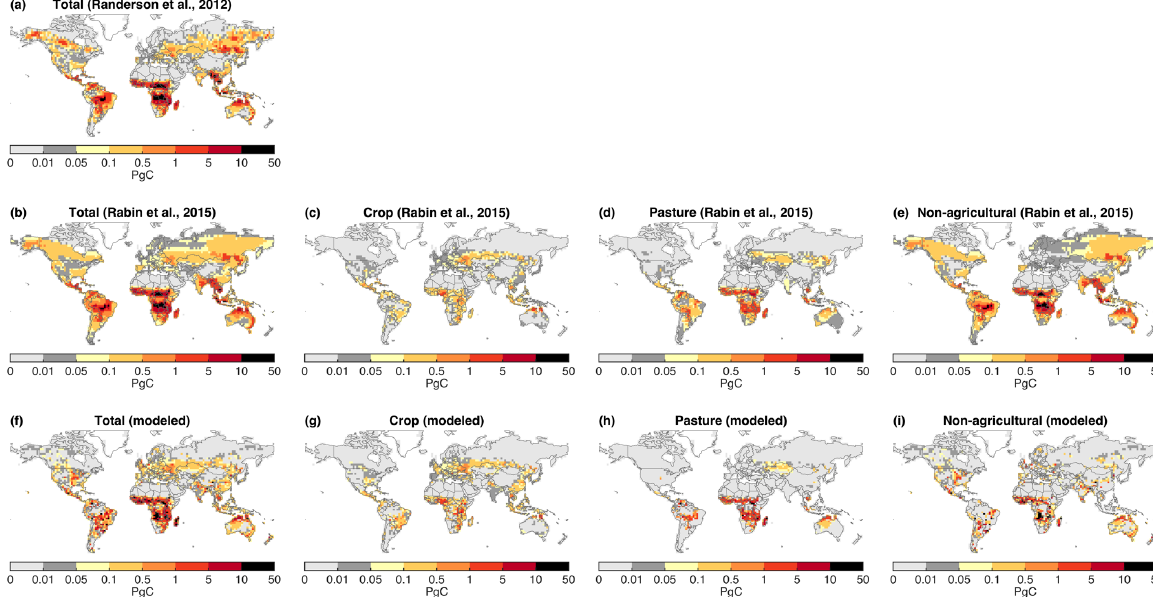
Figure 8. Mean annual fire carbon emissions. (a) : from GFED3s (Randerson et al., 2012); (b–e) : observational estimates from unpacking analysis; (f–i) :